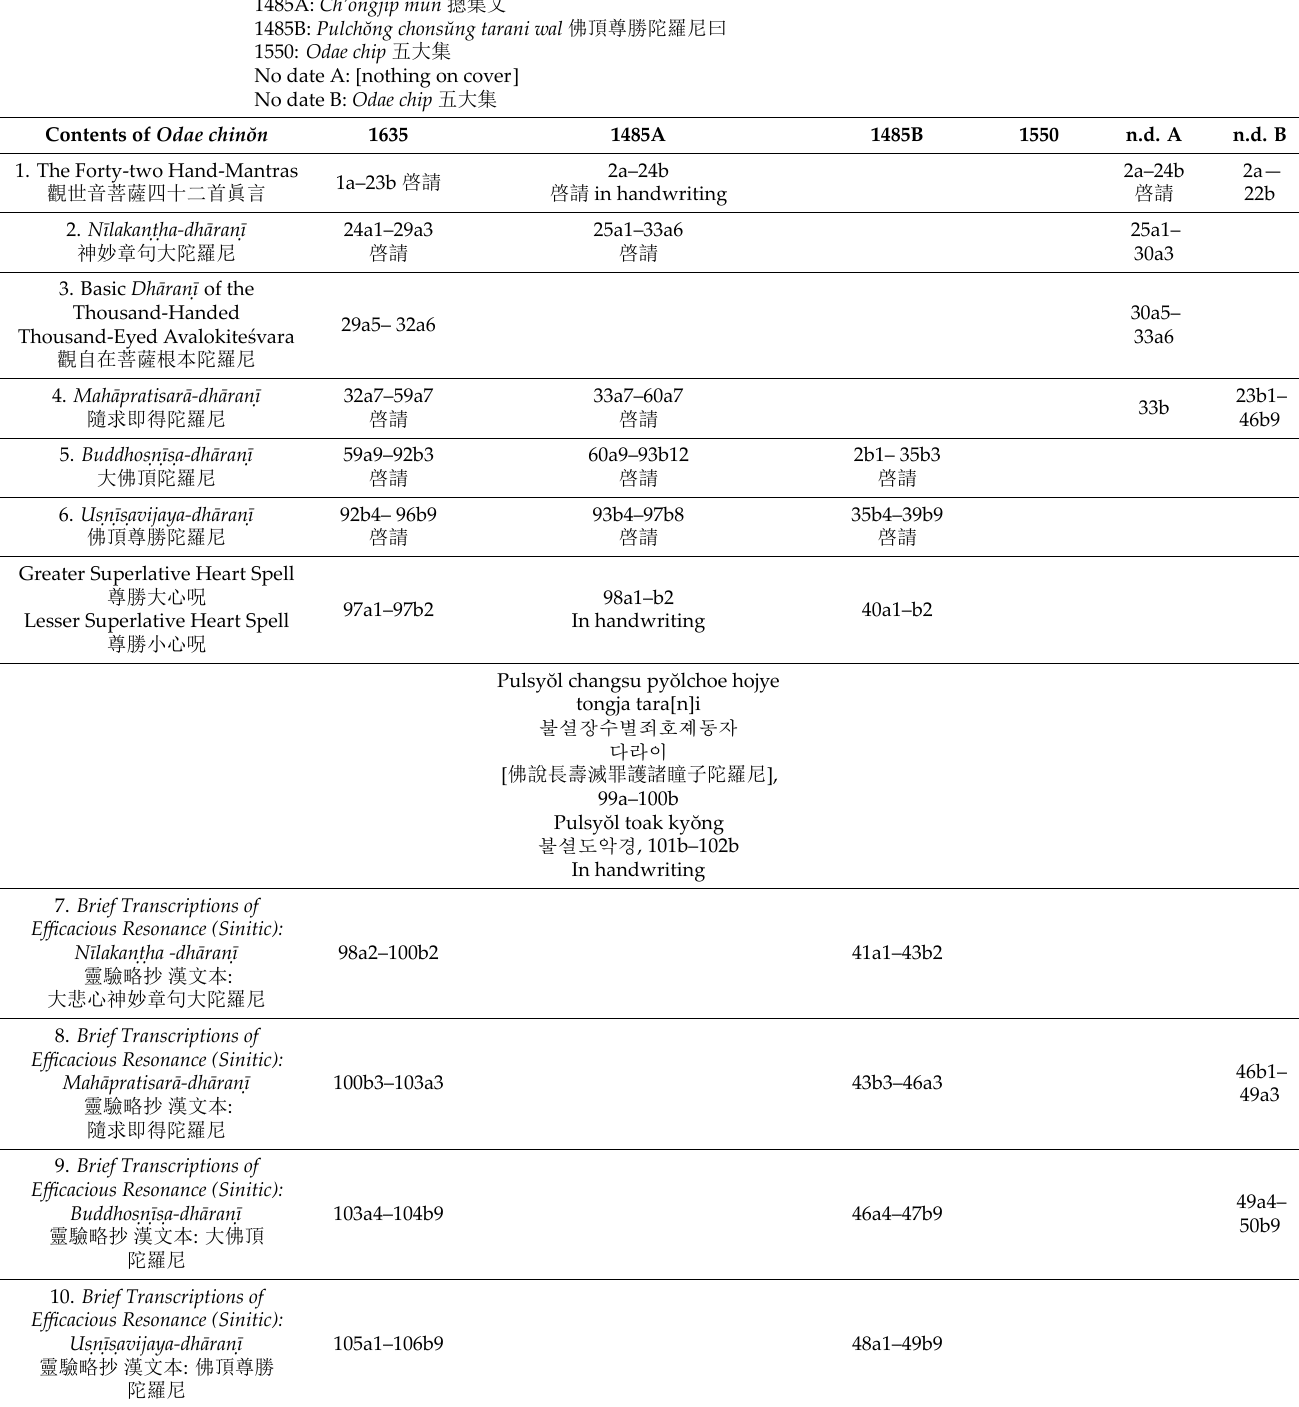
Table 1. Comparison of Odae chinŏn